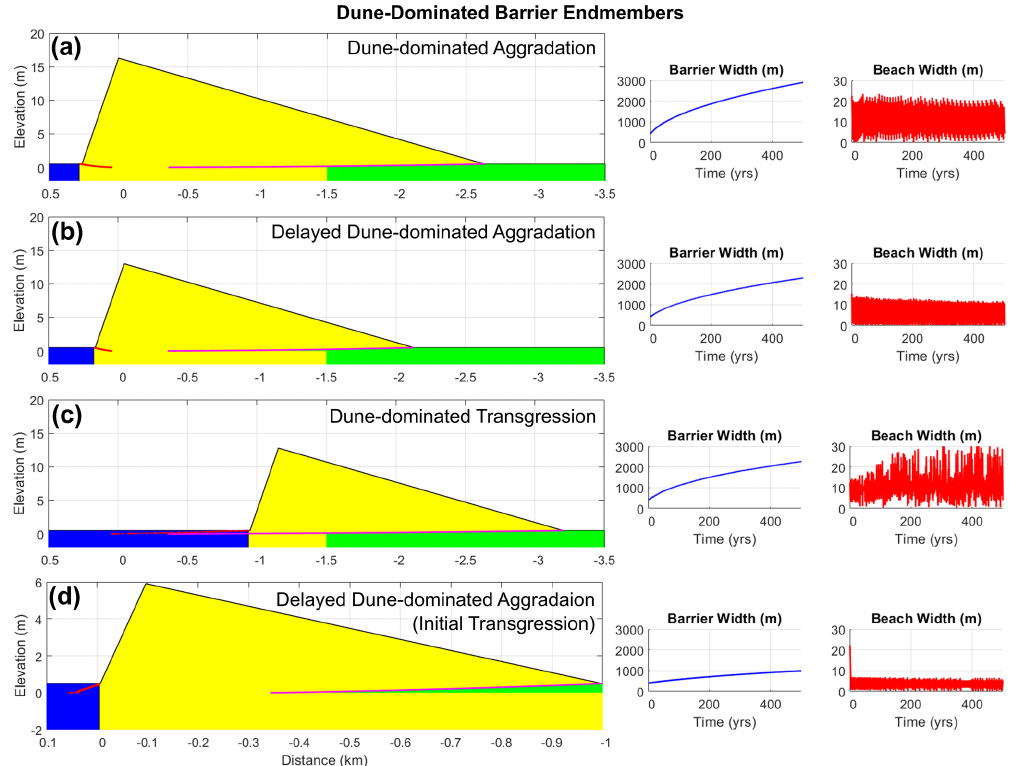
Figure 12. Simulated barriers at 500 years post-initialization. (a) Dune-dominated aggradation concomitant with 48m 3 m − 1 yr − 1 of shoreface flux and 60m 3 m − 1 yr − 1 of foredune flux. (b) Delayed dune-dominated aggradation at 30m 3 m − 1 yr − 1 of shoreface flux and 60m 3 m − 1 yr − 1 of foredune flux. (c) Dune-dominated transgression at 23m 3 m − 1 yr − 1 of shoreface flux and 60m 3 m − 1 yr − 1 of foredune flux. (d) Delayed dune-dominated aggradation (pronounced initial transgression) at 5m 3 m − 1 yr − 1 of shoreface flux and 22m 3 m − 1 yr − 1 of foredune flux. Yellow represents barrier sand, blue represents ocean, green represents marsh. The solid magenta line tracks the position of the barrier–marsh interface, while the dashed red line tracks the shoreline position through